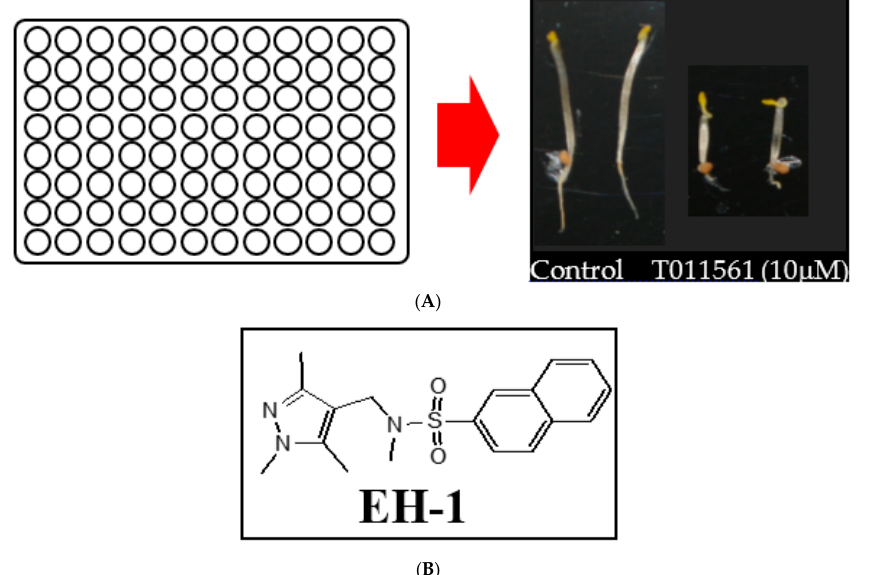
Figure 1. A screen for chemicals with activity to induce triple response in Arabidopsis seedlings. ( A